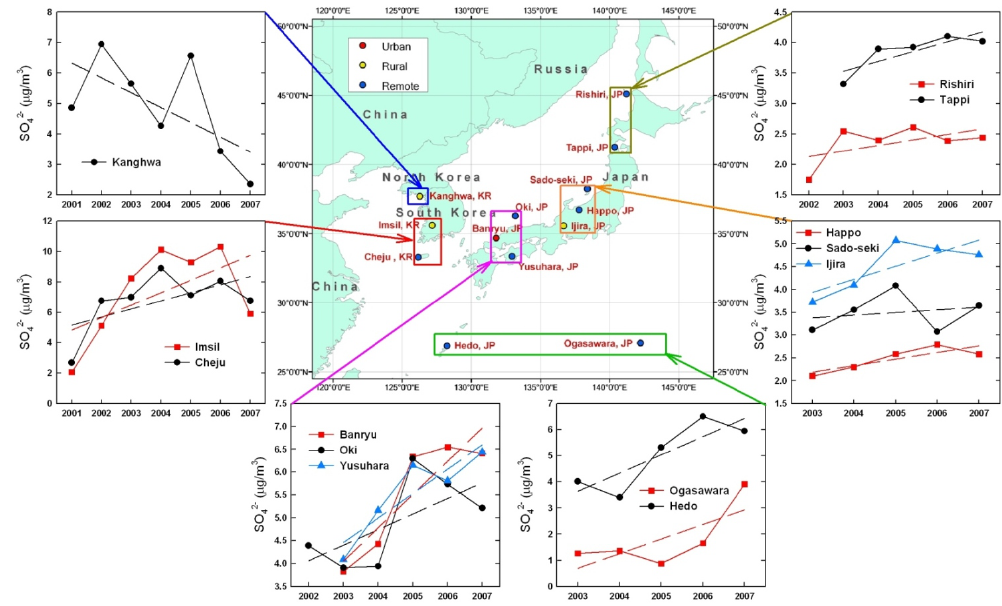
Fig. 12. Inter-annual trends of SO 2 − in PM at 13 EANET sites from 2001 to 2007. Dashed lines represent the linear tendencies. 4